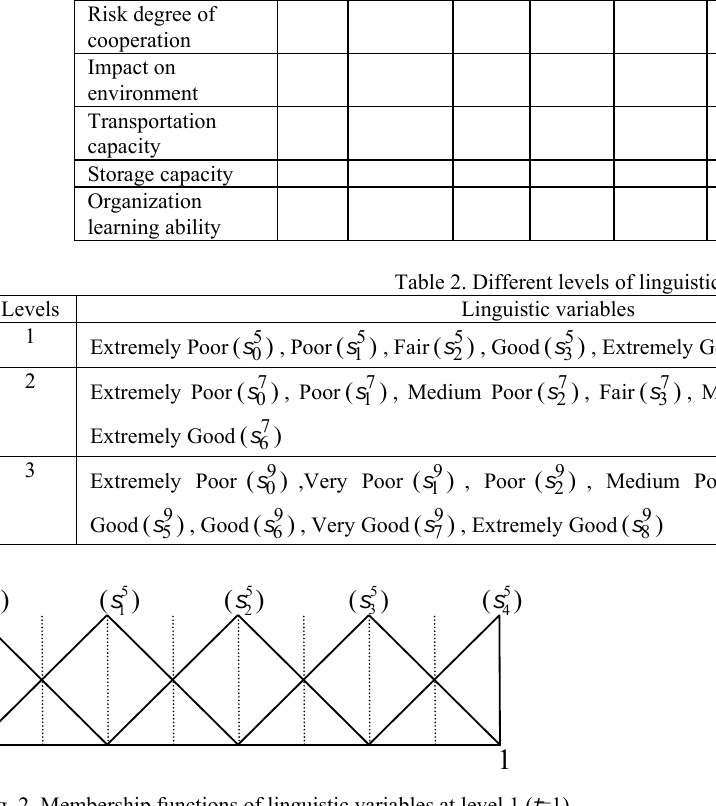
Fig. 2. Membership functions of linguistic variables at level 1 ( t =1)